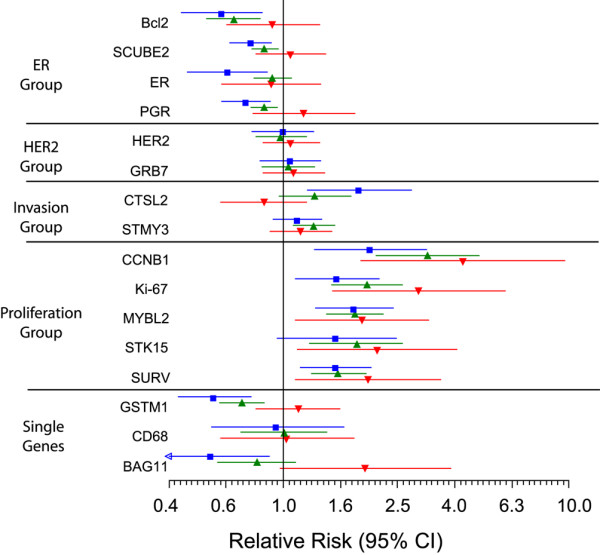
Relative risks (RRs) for death associated with expression of single genes. Findings are stratified by tamoxifen treatment and ER status. The position of each symbol indicates the RR. The length of the horizontal line through the symbol indicates the 95% CI. The blue boxes indicate the RRs and 95% CIs for ER-positive patients treated with tamoxifen, the green pyramids indicate the RRs and 95% CIs for ER-positive patients not treated with tamoxifen, and the red downward pointing triangles indicate the RRs and 95% CIs for ER-negative patients not treated with tamoxifen. CI, confidence interval; ER, estrogen receptor; RR, relative risk.